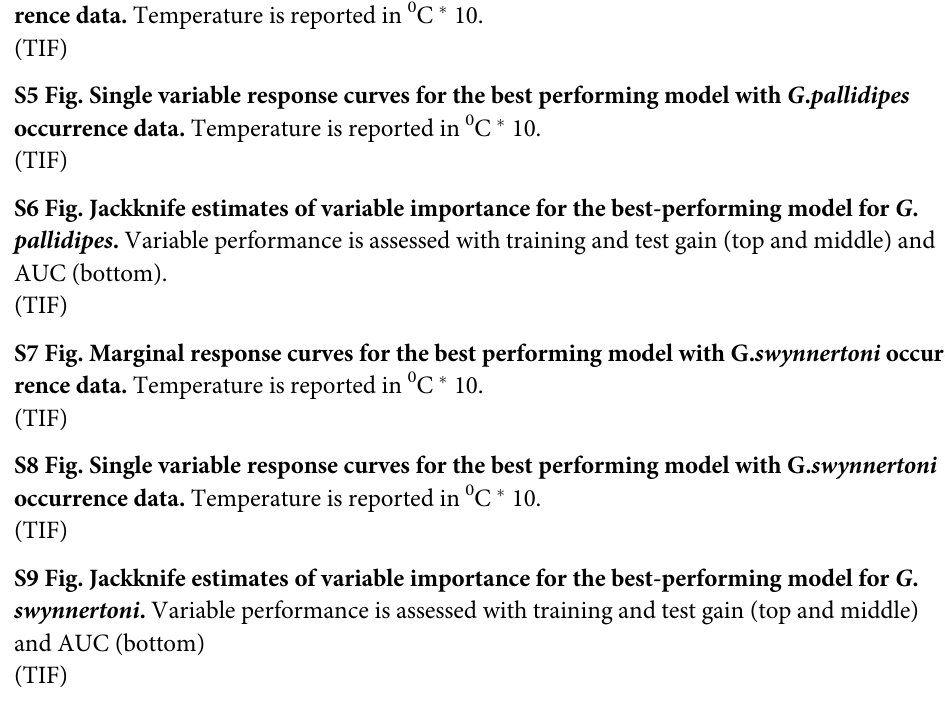
S1 Fig. Marginal response curves for the best performing model with G . m . morsitans occur- rence data. Temperature is reported in 0C � 10. S2 Fig. Single variable response curves for the best performing model with G . m . morsitans occurrence data. Temperature is reported in 0C � 10. S3 Fig. Jackknife estimates of variable importance for the best-performing model for G . m . morsitans . Variable performance is assessed via the variables’ impact to training and test gain (top and middle) and AUC (bottom). S4 Fig. Marginal response curves for the best performing model with G . pallidipes occur- rence data. Temperature is reported in 0 C � 10. S5 Fig. Single variable response curves for the best performing model with G . pallidipes occurrence data. Temperature is reported in 0 C � 10. S6 Fig. Jackknife estimates of variable importance for the best-performing model for G . pallidipes . Variable performance is assessed with training and test gain (top and middle) and AUC (bottom). S7 Fig. Marginal response curves for the best performing model with G. swynnertoni occur- rence data. Temperature is reported in 0 C � 10. S8 Fig. Single variable response curves for the best performing model with G. swynnertoni occurrence data. Temperature is reported in 0 C � 10. S9 Fig. Jackknife estimates of variable importance for the best-performing model for G . swynnertoni . Variable performance is assessed with training and test gain (top and middle) and AUC (bottom)